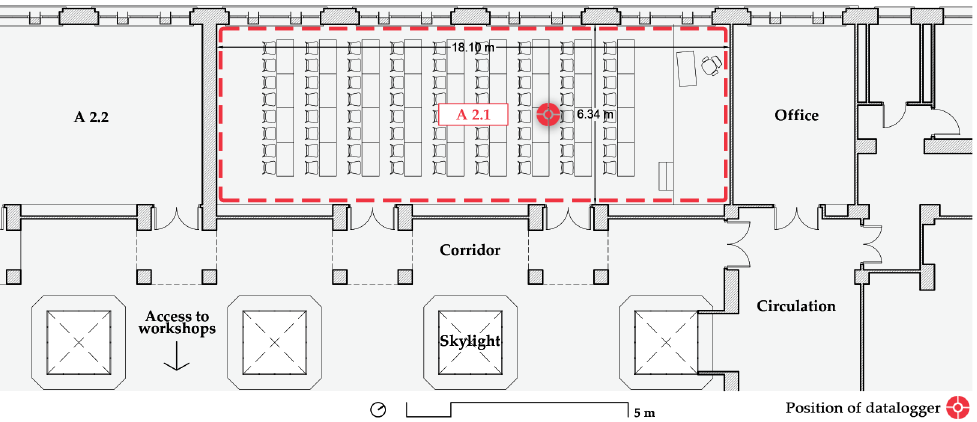
Figure 6. Floorplan of the studied classrooms. A 2.1 on the second floor (top) and A 1.1 on the first floor (bottom). Source: authors.